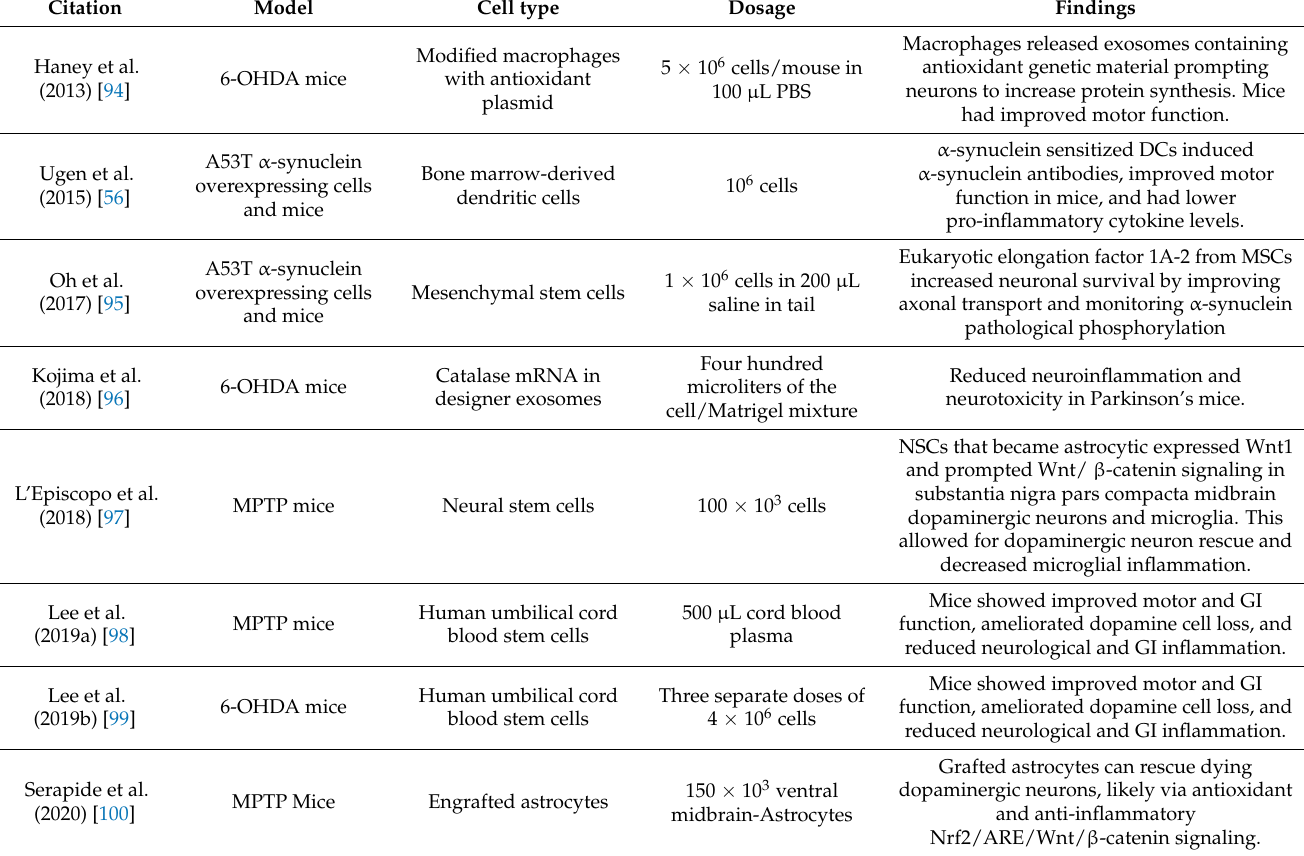
Table 1. Pre-clinical anti-inflammatory stem cell studies for Parkinson’s